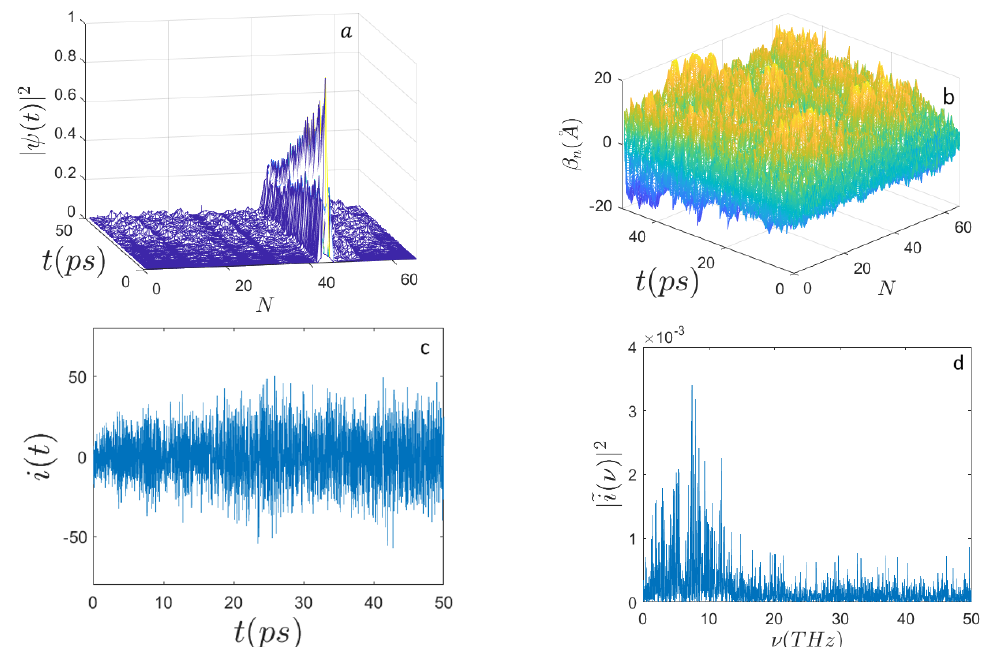
Figure 8. Time evolution of ( a ) the electron probability amplitude | Ψ ( t ) | 2 ; ( b ) the average displace- ments β n ( ˚ A ) ; ( c ) the electron current i ( t ) (expressed in µ biot); ( d ) the frequency spectrum | ˜ i ( ν ) | 2 along the sequence of N = 66 nucleotides with the initial conditions E 0 = 0.9 eV ( E (cid:48) = 136.7) and the initial electron excitation peaking around the site n 0 = 2 N /3. The other parameters are the same as those in Figure